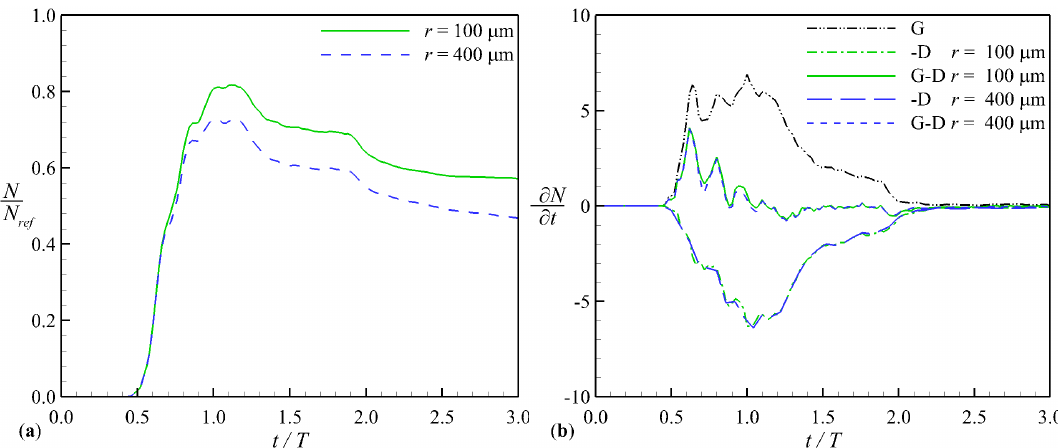
Figure 10. Time histories of ( a ) the number of droplets N / N ref , and ( b ) generation rate GT / N ref and disappearance rate − DT / N ref of droplets in Case